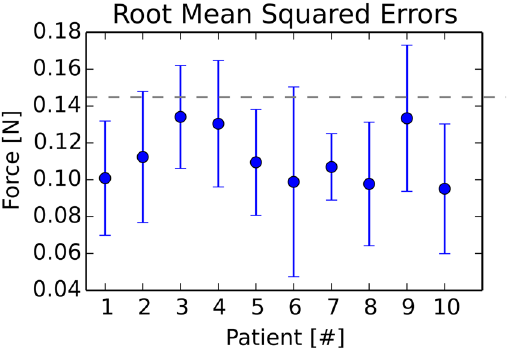
Figure 6. Change of segmentation model: Force metric RMSE per